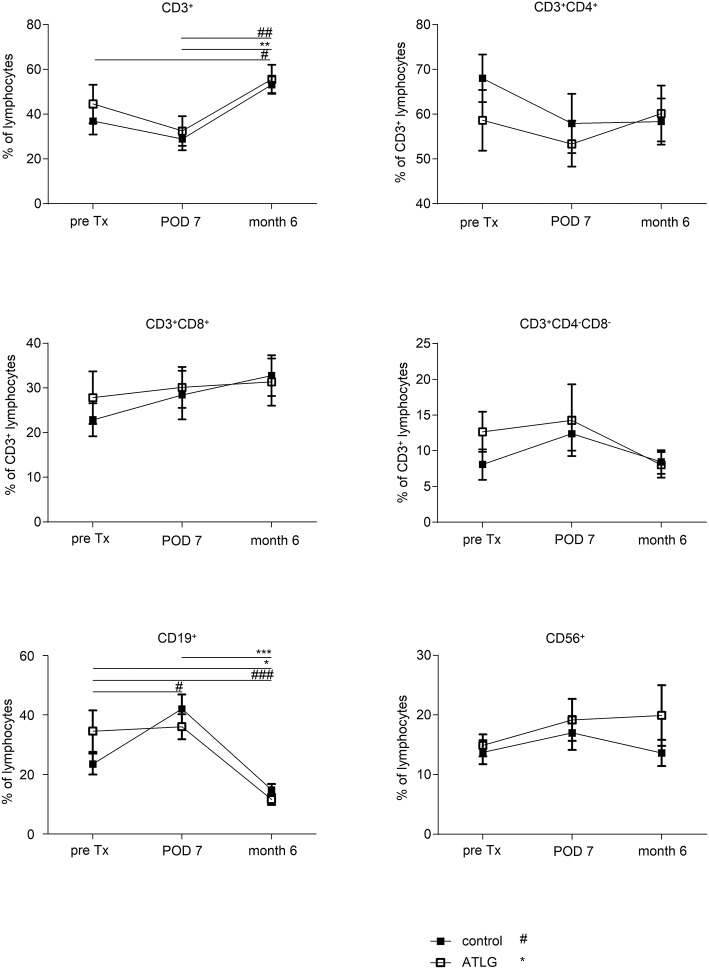
Frequencies of major lymphocyte subsets in the peripheral blood of kidney recipients. Recipients who received an ATLG-perfused organ and those who received a saline-perfused organ illustrated similar frequencies of CD3+, CD4+, CD8+ T cells, CD4−CD8− T cells, CD19+ B cells, and CD56+CD3− NK cells. Interestingly, whereas T cell frequencies appeared to decrease in the early postoperative days, there was a significant increase between day 7 post-transplantation (POD 7) and month 6 (p = 0.0078, respectively). Moreover, both patient groups show a significant decrease in CD19+ B cells as compared with pre-transplant levels and POD7 (p = 0.001, respectively). ATLG: open boxes, control: filled boxes; data are presented as mean ± SEM; *p < 0.05, **p ≤ 0.01, ***p ≤ 0.001; *, difference within AP; #, difference within CP; ## < 0.01, ### < 0.001.